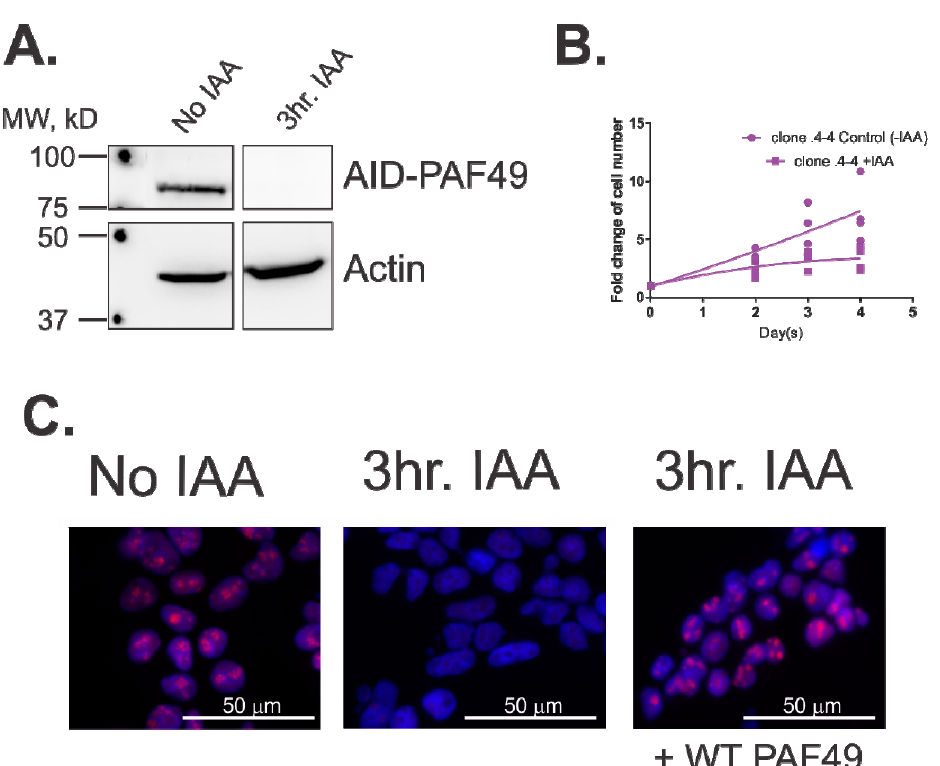
Figure 5. PAF49 is required for cell proliferation and rDNA transcription. ( A ) IAA induces the rapid degradation of AID-PAF49. The endogenous PAF49 gene in HEK293 cells was tagged with an auxin-inducible degron (AID) [38]. Cells were treated with or without indole-3 acetic acid (IAA) for 3 h. Whole-cell extracts were prepared, and levels of PAF49 were determined via Western blot analysis. ( B ) PAF49 is required for proliferation. Cells containing AID-PAF49 were treated with or without IAA for 4 days. On days 0, 2, 3, and 4, live cells were counted as described [38]. ( C ) PAF49 is required for pre-rRNA synthesis. After cells were treated with IAA for three hours, they were pulsed with 5-ethyl uridine (EU) for 15 min, and de novo synthesized RNA was visualized as described (red) against a DAPI background [51]. To rescue rDNA transcription, wild-type mouse PAF49 (WT PAF49) was ectopically expressed for 24 h before the cells were treated with IAA.